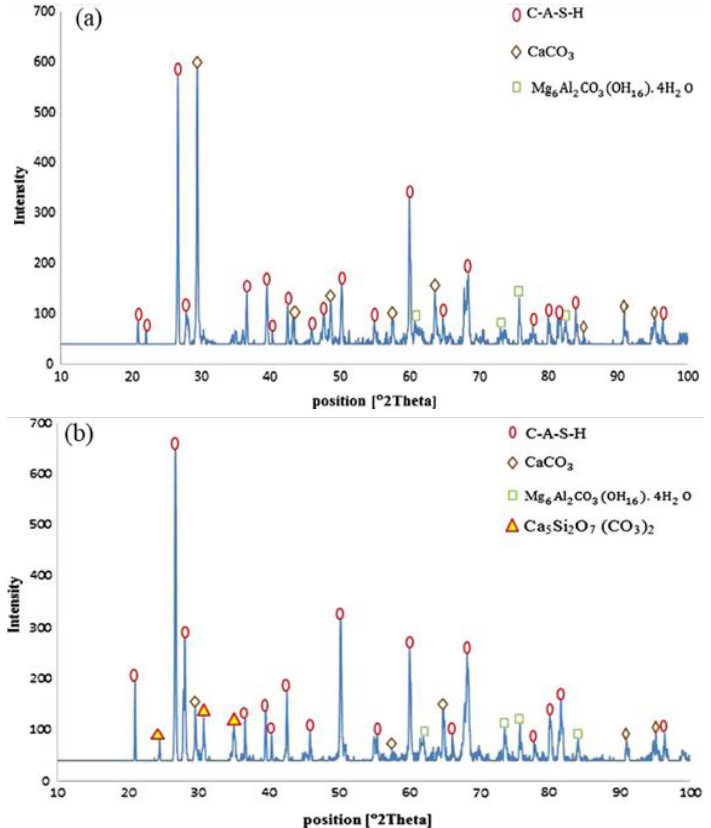
Figure 10. XRD pattern and phase analysis of ( a ) control sample and ( b ) nanosilica-containing slag-based AAM concrete [127].